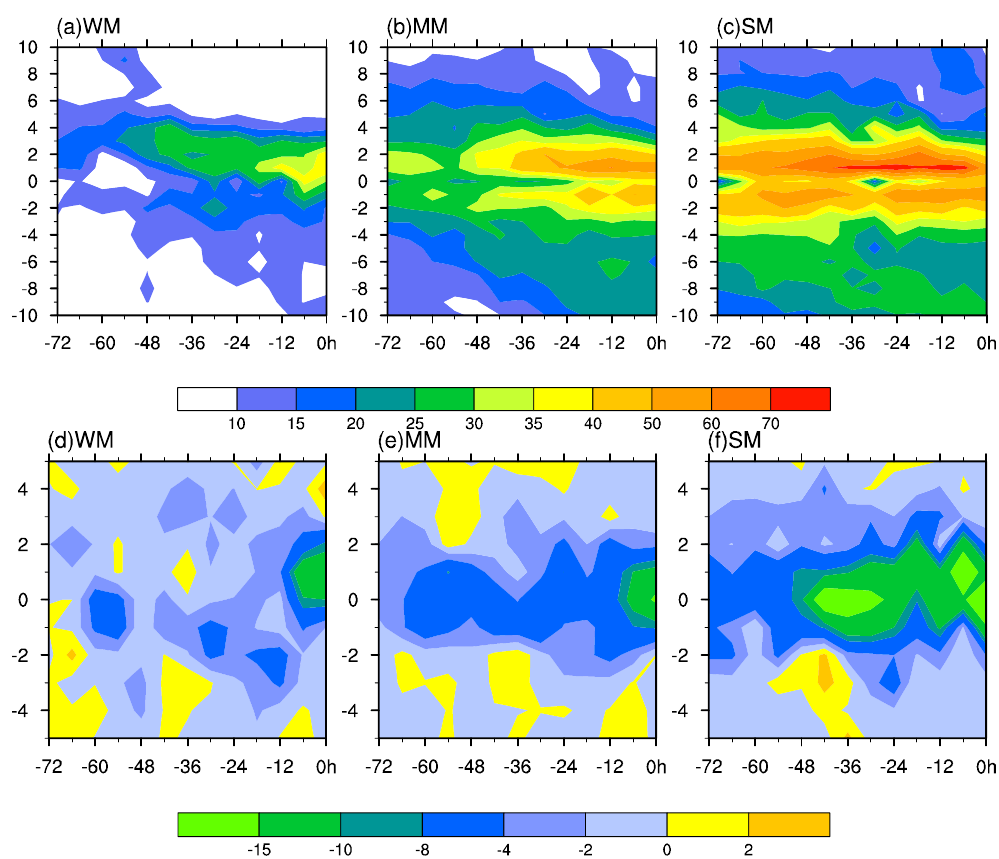
Figure 7. Dynamic composite of the meridional water vapor flux ( a – c , g s − 1 hPa − 1 cm − 1 ) and water vapor flux divergence ( d – f , 10 − 4 kg m − 2 s − 1 ) passing typhoon centers at 925 hPa from 72 h before landfall to the landfall time. ( a , d ) Cluster WM, ( b , e ) cluster MM, ( c , f ), and cluster SM. Vertical and horizontal ordinates are degrees of latitude away from typhoon centers and hours before the LSTYs landfall (0 h).